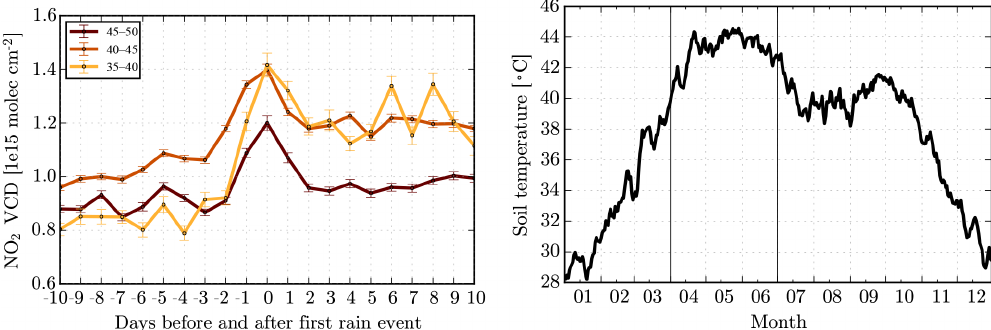
Figure F1. In this figure, NO 2 VCDs are shown (akin to Fig. 5e) from OMI around the first day of rainfall for different soil temperatures on Day0 for the Sahel region (left panel). The right panel depicts daily time series of soil temperature (from 12:00UTC ECMWF data) for